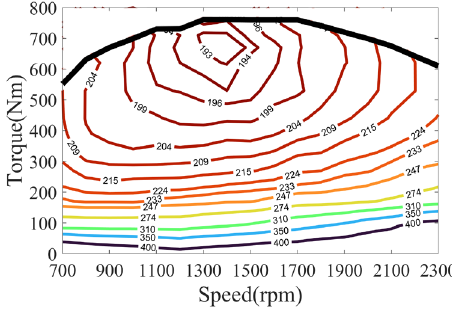
Figure 2. The fuel consumption rate MAP of the engine.